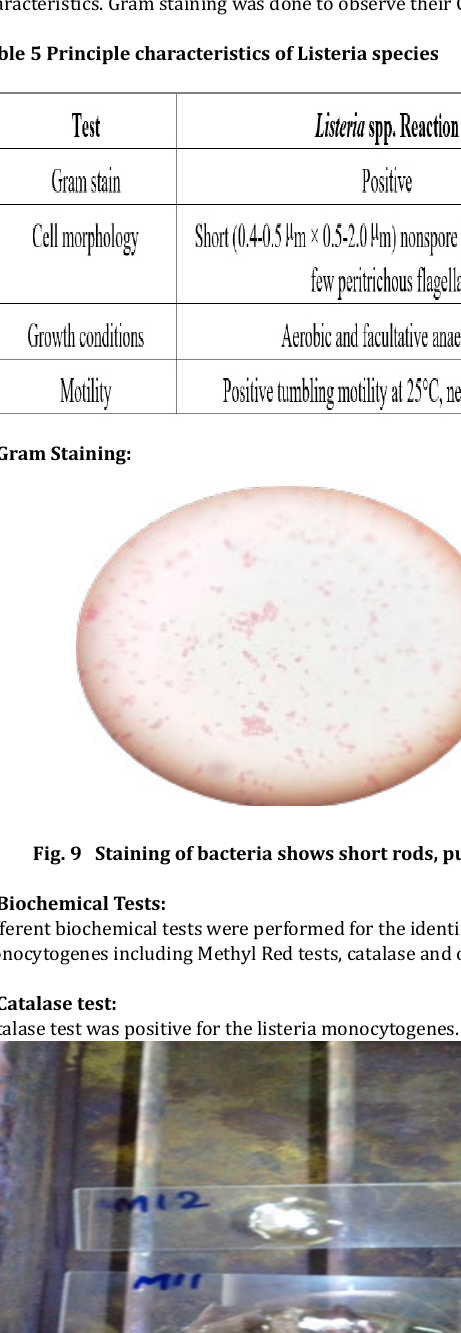
Fig. 5 Streaking of samples on selective agar